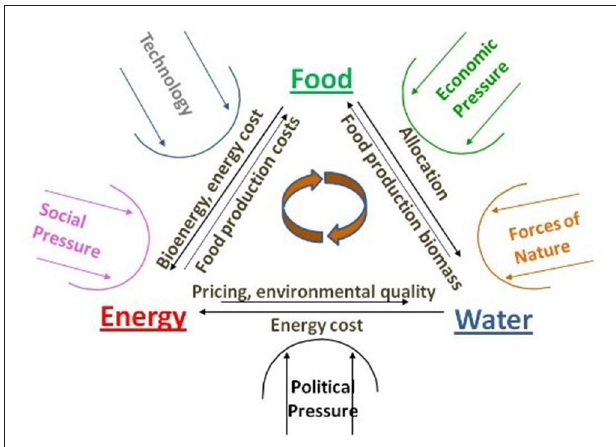
FIGURE 1 | The sustainability triangle (Mohtar,